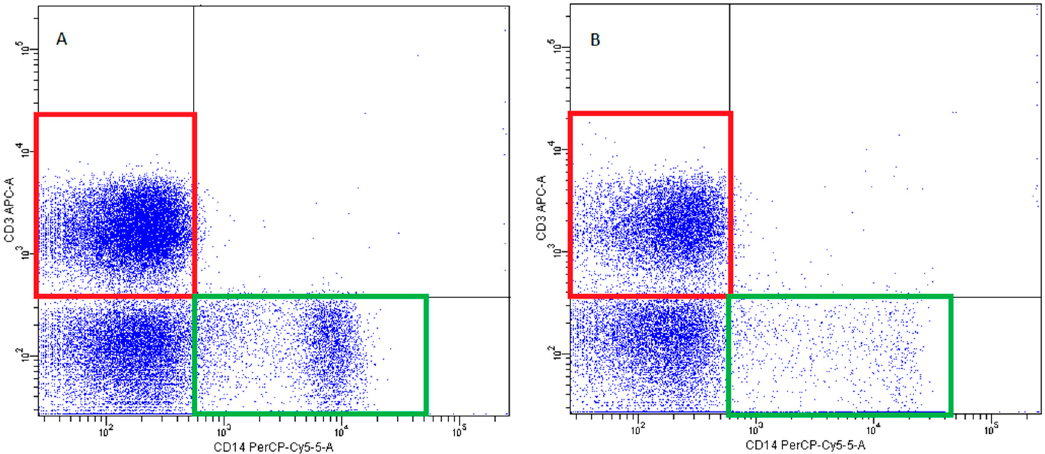
Figure 14. Exemplary plots of flow cytometry analysis showing the staining with antibodies specific for CD3 (T lymphocytes—red gates) and CD14 (monocytes—green gates) in mononuclear leukocyte fraction: ( A ) peripheral blood ( B ) FNAB.